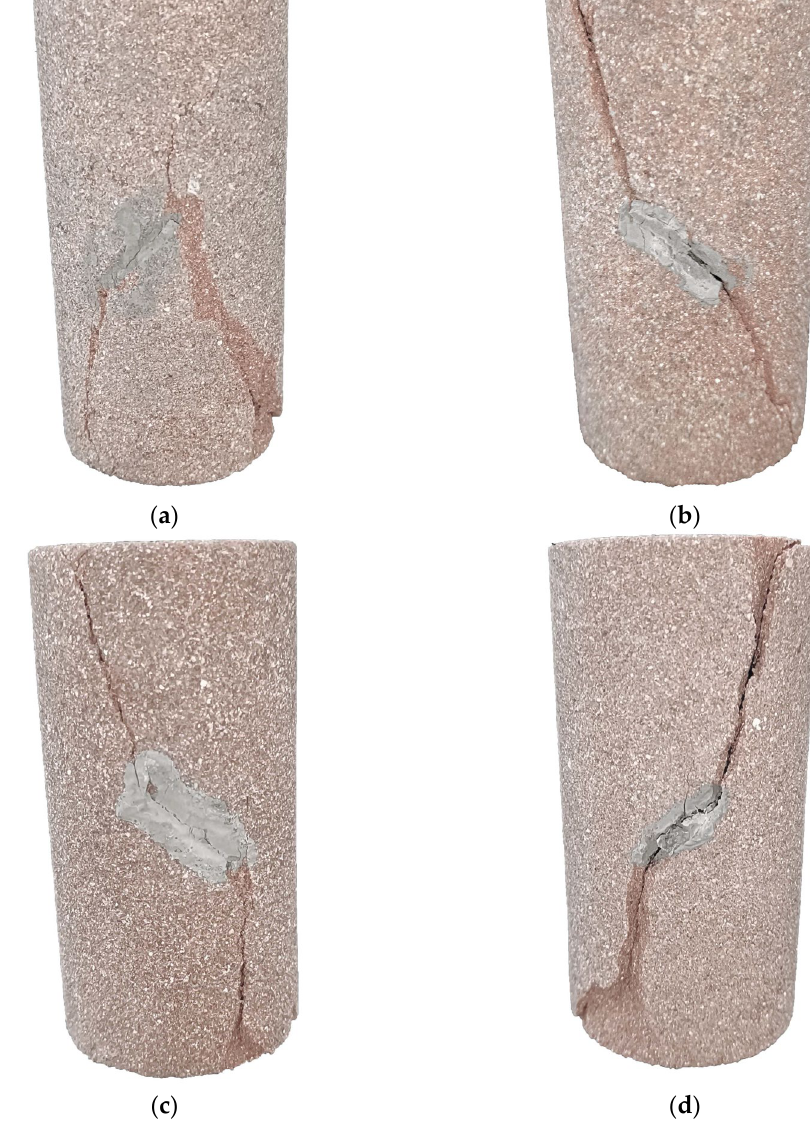
Figure 6. Failed specimens under different cycles. ( a ) 0 cycles. ( b ) 5 cycles. ( c ) 10 cycles. ( d ) 20 cycles.